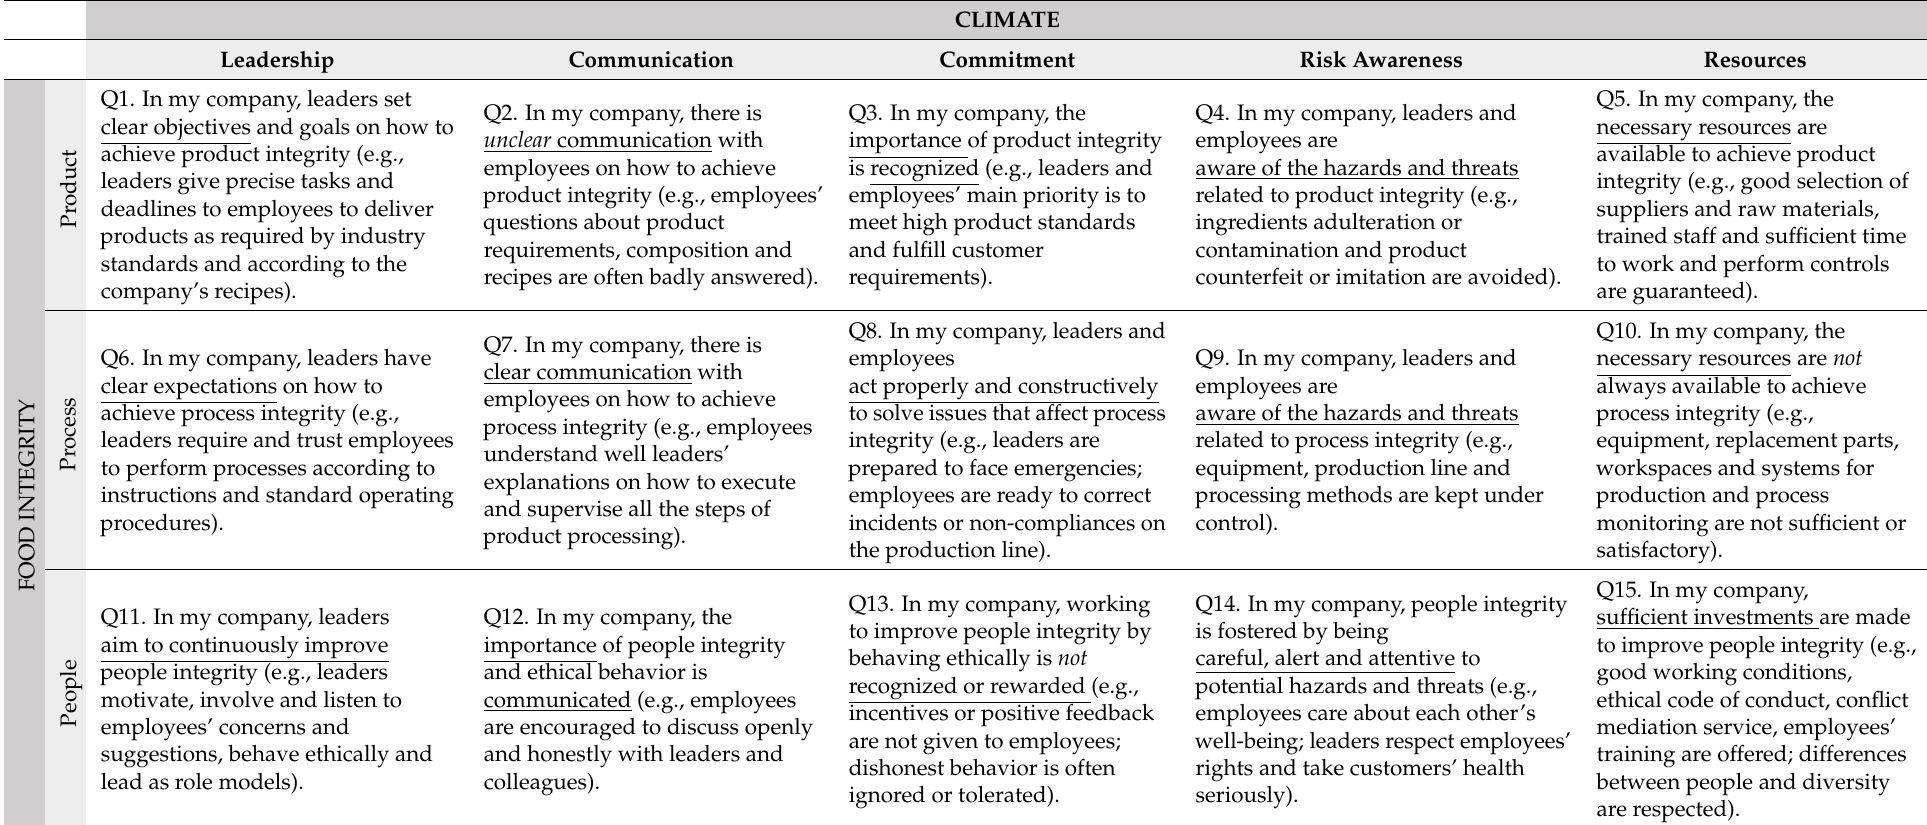
Table 1. Matrix of the twenty food integrity climate self-assessment tool indicators. Indicators are formulated by matching the notions of the four food integrity elements (product, process, people, and data integrity) [8] with those of the five climate components (leadership, communication, commitment, risk awareness, and resources) [16], adapted to assess food integrity. Each of the four food integrity elements is represented through five indicators and all indicators include a practical example to facilitate respondents’ comprehension of the statements. Questions 2, 10, 13, and 17 are formulated negatively to ensure accurate and unbiased responding. Participants are instructed to score each statement on a five-point Likert scale 1 → 5: strongly disagree, disagree, not agree nor disagree, agree, strongly agree. The four negatively formulated statements are recoded in reverse during data processing (5 → 1: strongly disagree → strongly agree). High scores reflect a high perceived food integrity climate. Through the food integrity climate self-assessment tool, managers’ and operators’ perceptions of a company’s food integrity level can be analyzed, acknowledging the human dimension involved in the decision-making processes. (See full questionnaire in Appendix